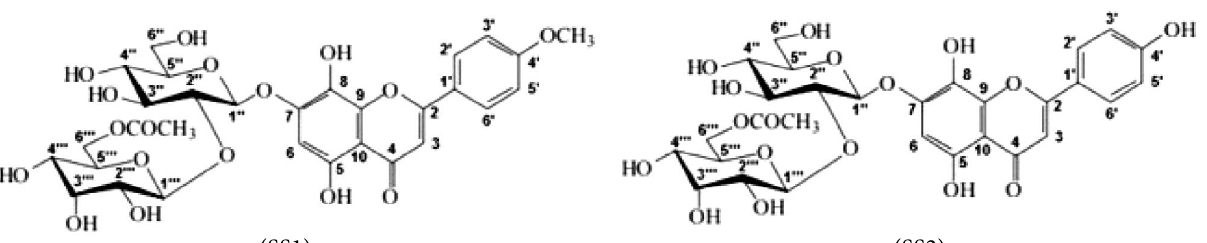
Figure 1. Chemical structures of major compounds isolated from S.